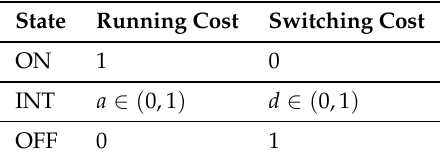
Table 1. A three-state power-down system with running cost a in the intermediate state INT and switching cost d to switch from INT to